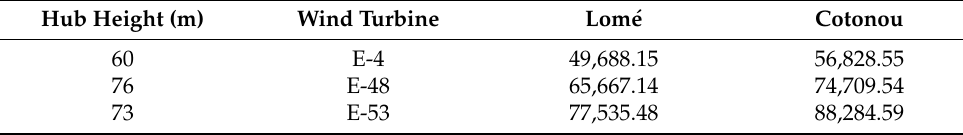
Figure 6. Characteristic power curve modeling for E-48.